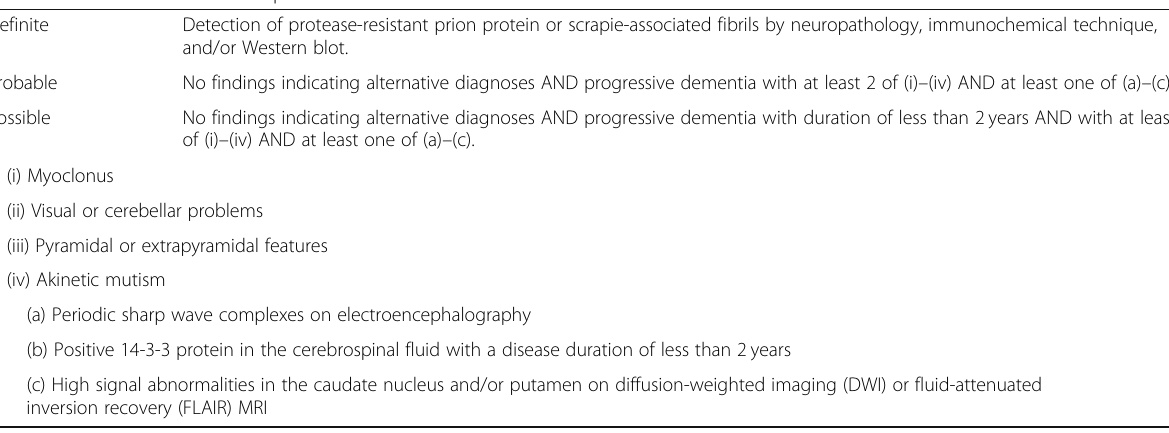
Table 1 2010 CDC Criteria for sporadic